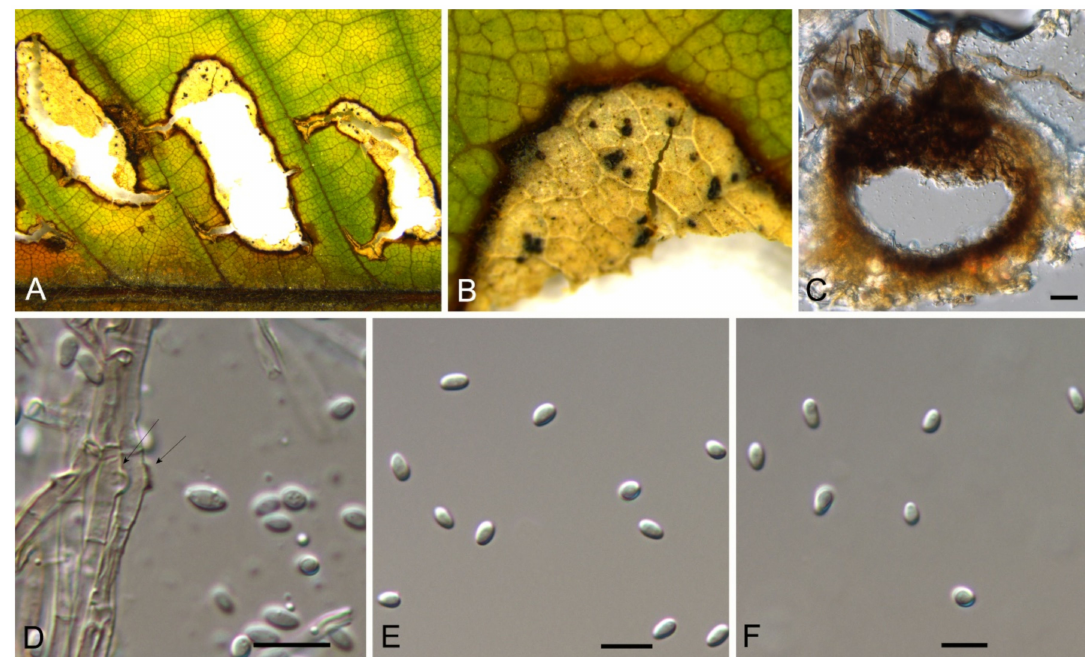
Figure 7. Didymella coffeae-arabicae (BJFC-S1792). ( A , B ) Conidiomata on the diseased leaves of Castanea mollissima ; ( C ) Section through the pycnidium; ( D ) Conidiogenous cells giving rise to conidia (arrows); ( E , F ) Conidia. Scale bars: ( C – F ) = 10 µ